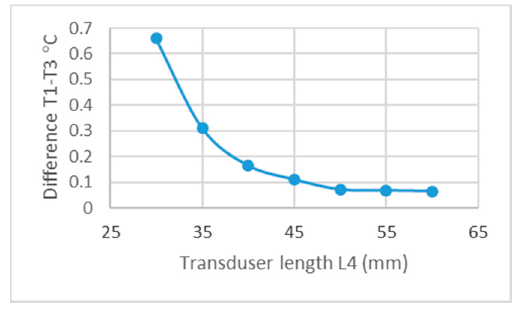
Figure 7. Influence of length L 4 on the T 1 – T 2 difference.